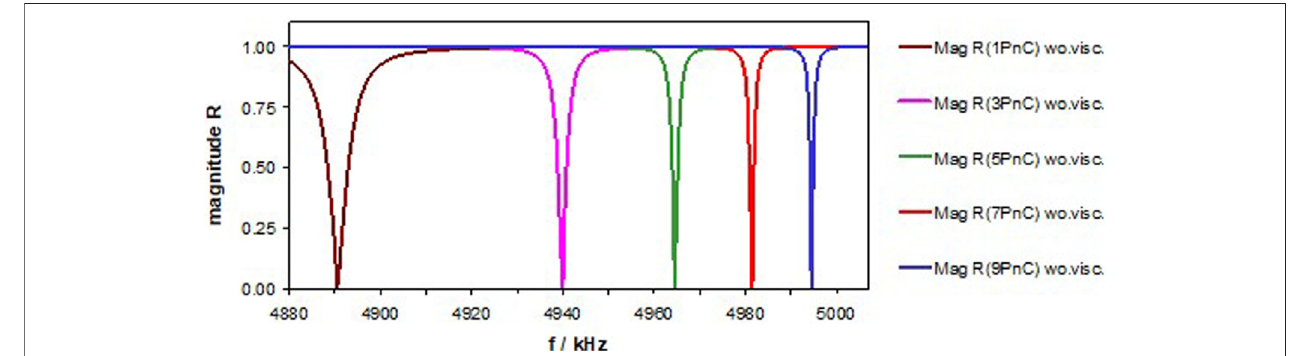
FIGURE 4| Magnitude of R at the interface between the xPnC and semi-in fi nite water. xrepresents the number ofmetal layers: the left and right of the central H 2 O layer. The viscosity of this H 2 O layer is assumed to be 0 (wo. visc.).